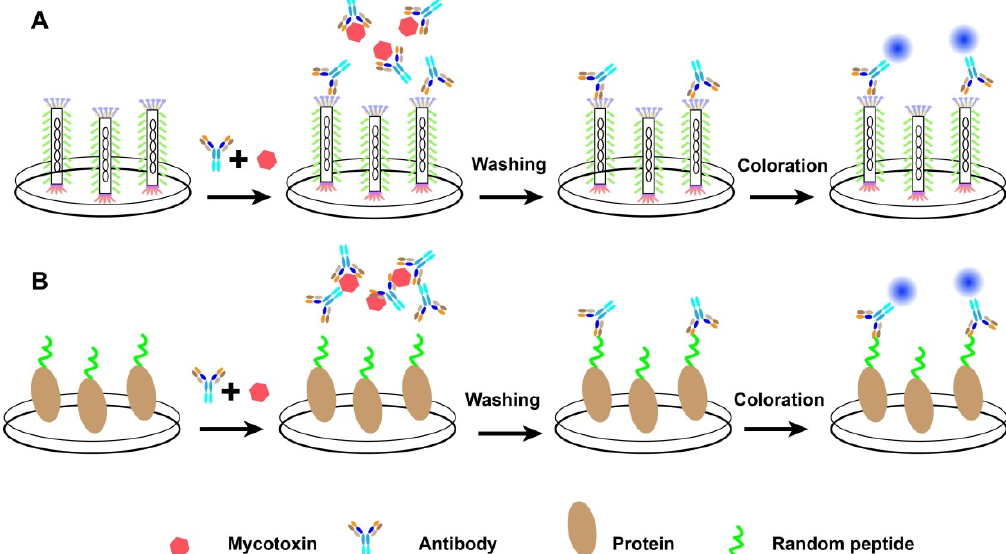
Figure 2. The process of competitive immunoassays based on phage form ( A ) or peptide fusion protein ( B ).